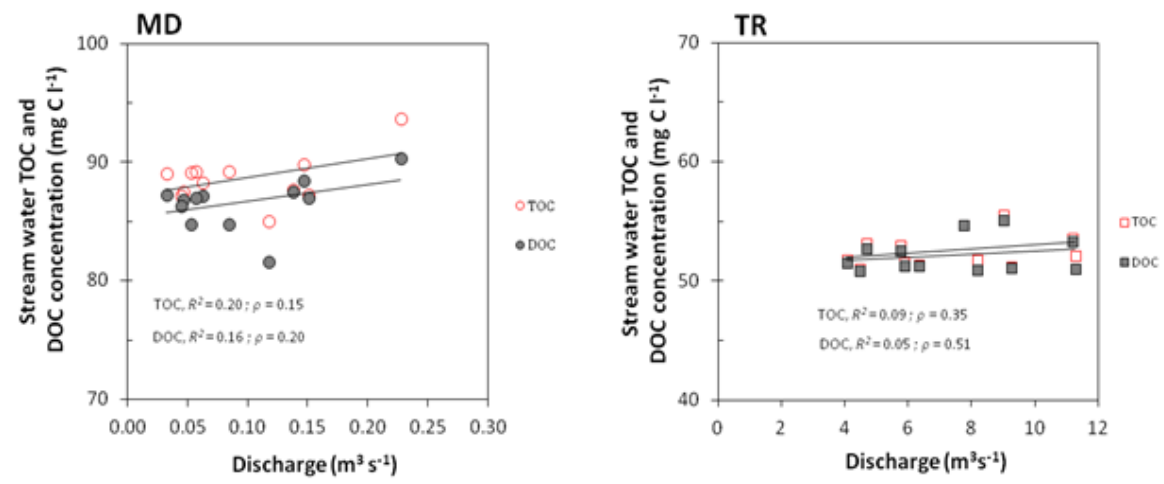
Figure 6. Relationships between TOC and DOC concentrations and stream discharge, in Meranti Ditch (MD) and Turip River